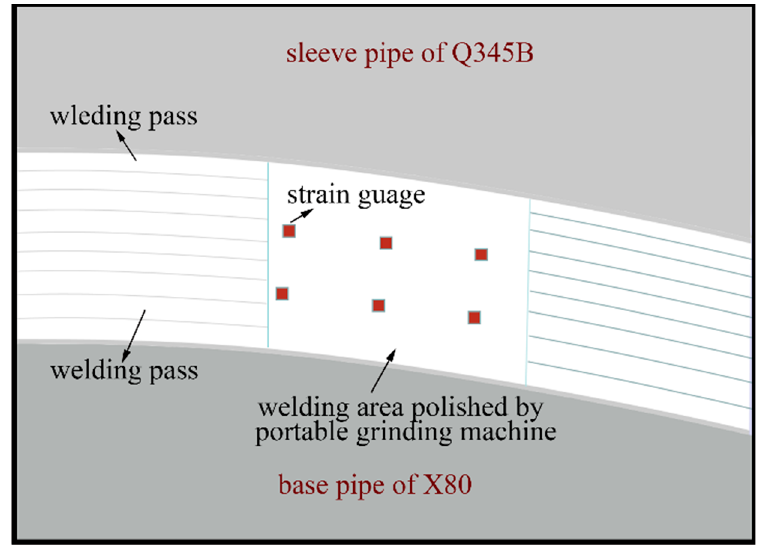
Figure 17. Schematic diagram of residual stress measurement.